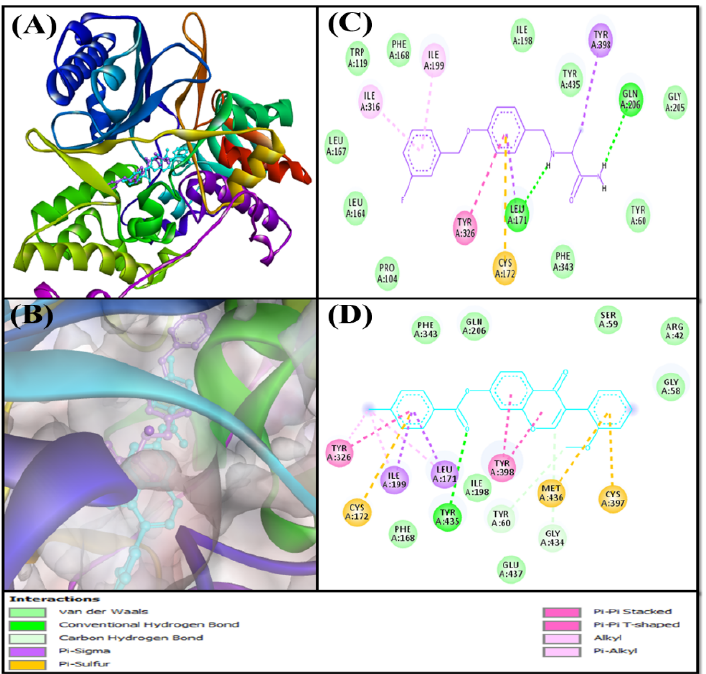
Figure 3. Interaction of target protein, MAO-A with F0850-4777 and their respective control ligands. ( A ) Position of F0850-4777 and Harmine in MAO-A. ( B ) Interactions between MAO-A and Harmine. ( C ) Superimposed image of F0850-4777 and Harmine in MAO-A. ( D ) Interactions between MAO-A and F0850-4777.